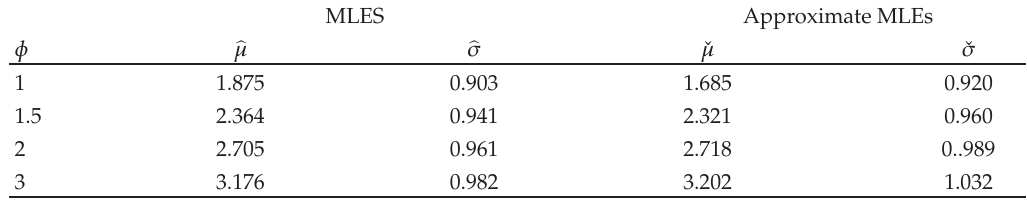
Table 1: MLEs of estimators and the approximated MLEs of estimators for φ (cid:7) 1 , 1 . 5 , 2, and 3. MLES Approximate MLEs